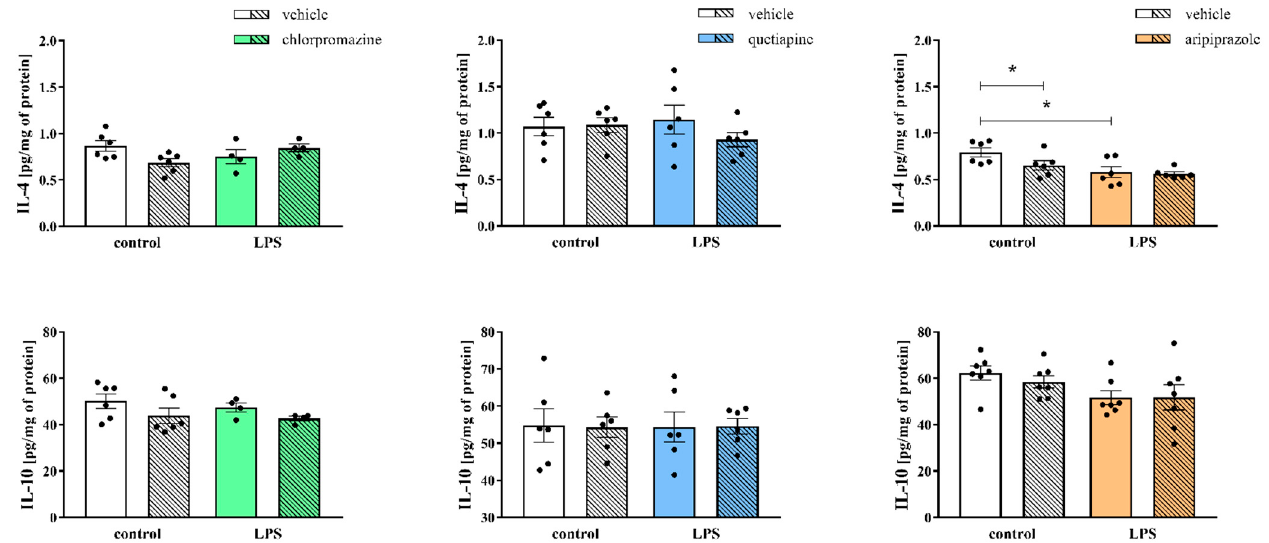
Figure 4. The impact of prenatal exposure to LPS and subsequent chronic treatment with chlorpromazine ( n = 4–6 in each group), quetiapine ( n = 6 in each group) or aripiprazole ( n = 6–7 in each group) on the levels of the anti-inflammatory proteins (IL-4 and IL-10) in the frontal cortices of the offspring. The results are presented as the mean ± SEM. * p < 0.05 vs. control + vehicle.